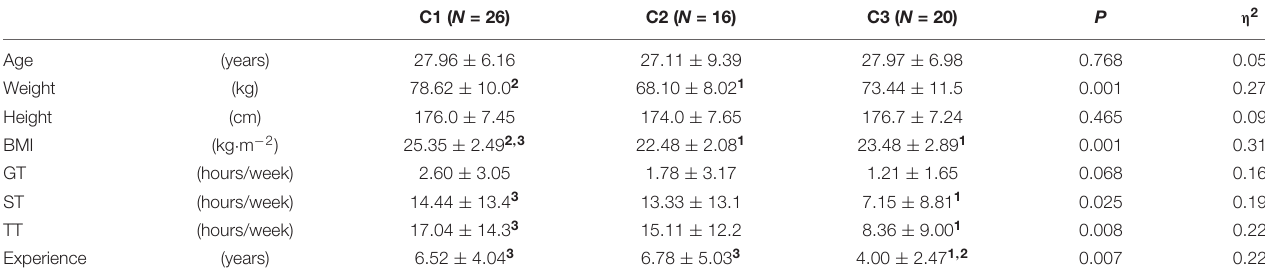
TABLE 1 | Characteristics of padel players depending on the